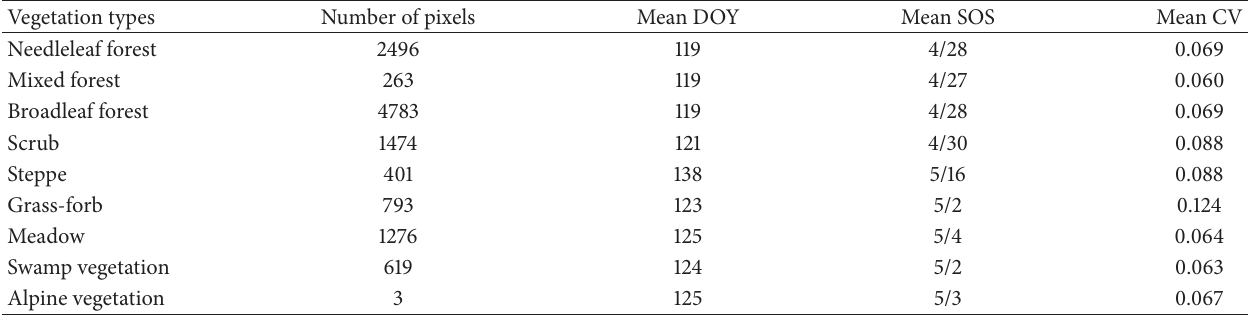
Table 3: The start of season (SOS) and coefficient of variation (1982–2006) averaged from the results of the five methods for each vegetation type.